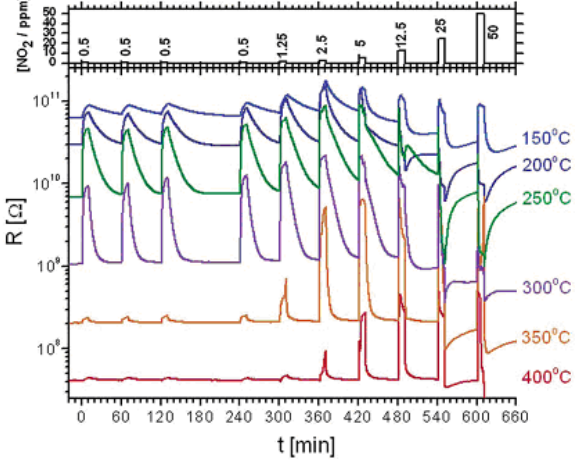
Figure 5. The resistance response during cyclic exposure to 10 min pulses with increasing concentrations of NO mixed in dry air at various operating temperatures 2